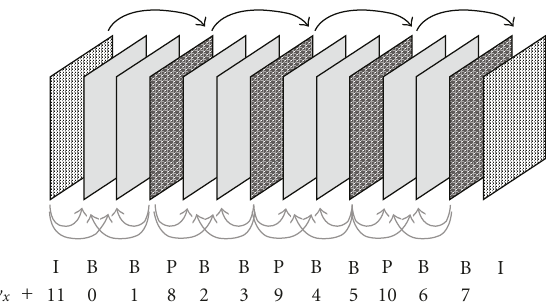
Figure 1: Demo of weight assignment for streaming data starting from w x .